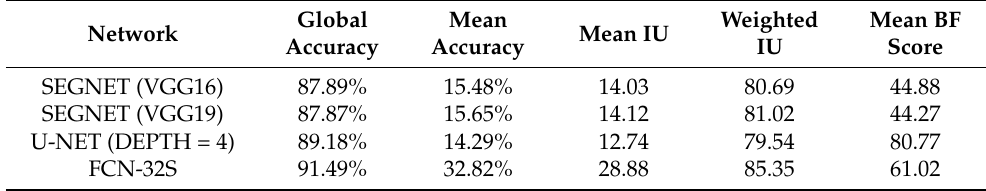
Figure 4. The visualization result of the semantic segmentation network output shows four original malignant tumor ultrasound images and the result after applying the semantic segmentation network. The original image and corresponded ground image are shown in the two columns on the far right. The semantic segmentation result from the first column on the left to the right: SegNet with VGG19 encoder, SegNet with VGG16 encoder, U-Net with depth equally four, and FCN-32s. Table 3. Performance results in SegNet, U-Net, and FCN-32s.